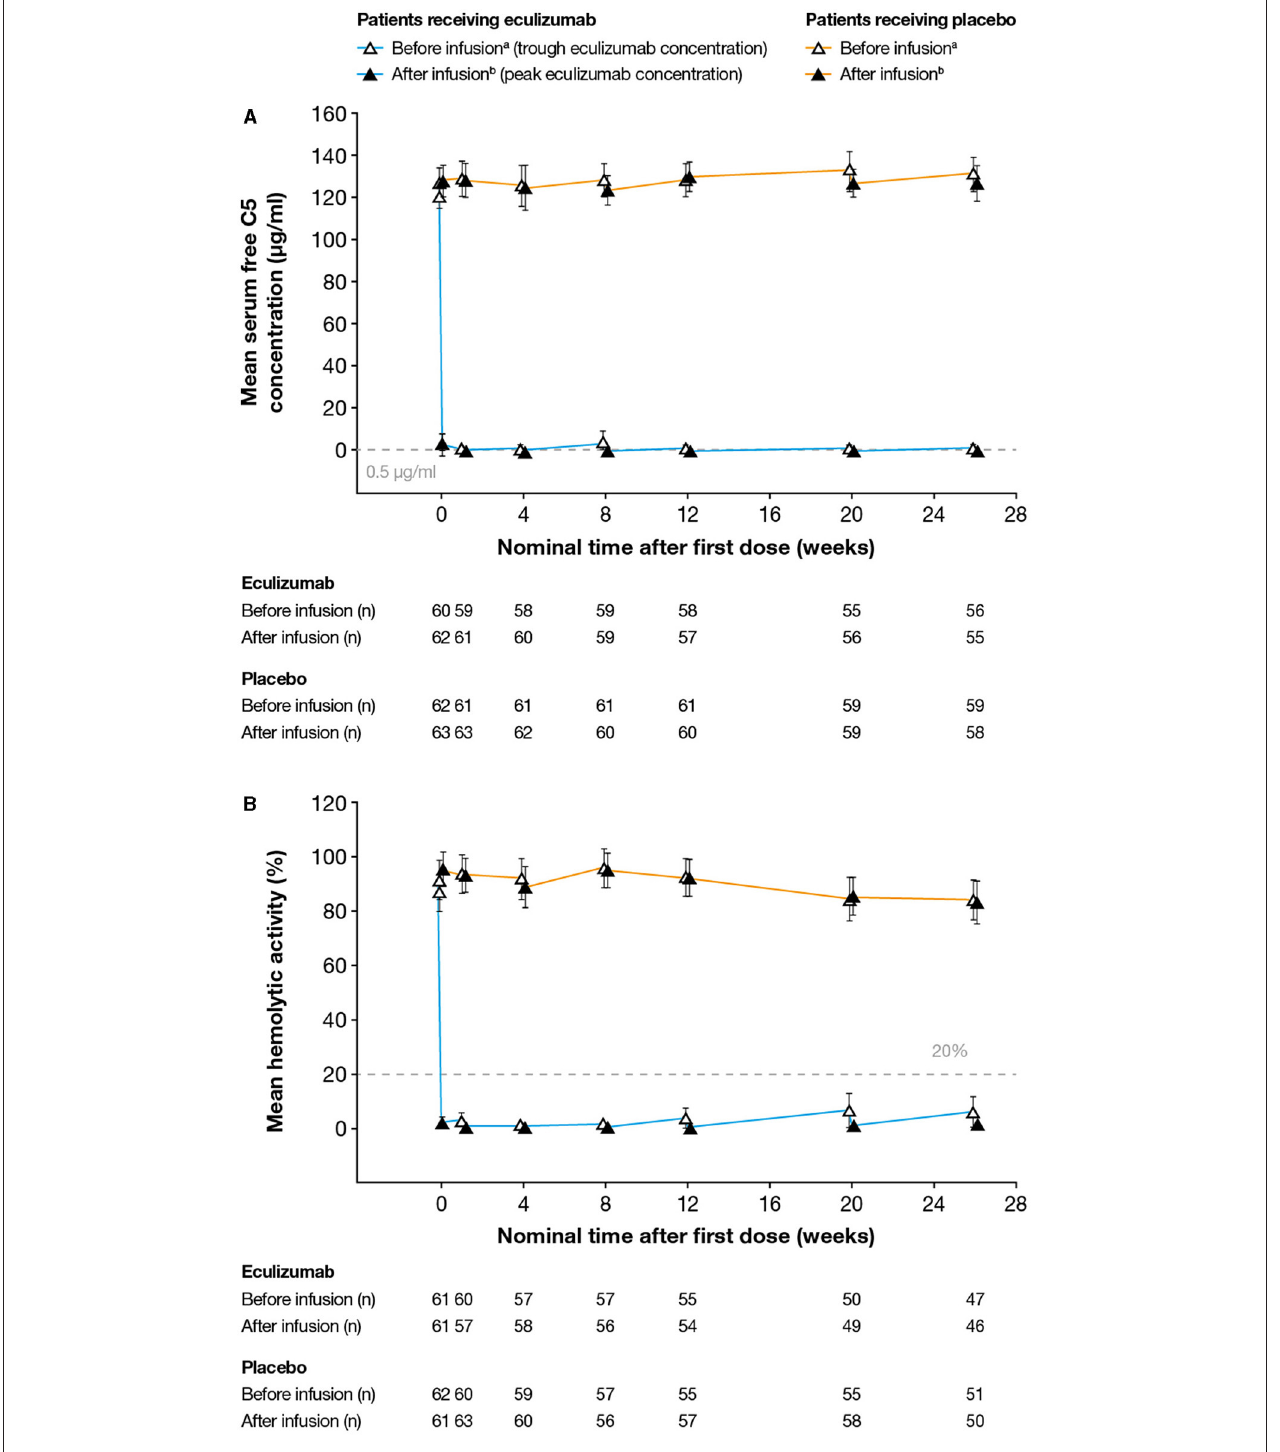
FIGURE 2 | Serum free C5 concentrations and complement-mediated hemolytic activity in serum during the study. (A) Mean (95% CI) serum free C5 concentrations. Free C5 concentrations below the lower limit of quantification (0.0274 µ g/ml) were analyzed as 0.0137 µ g/ml. Free C5 concentrations below 0.5 µ g/ml (dashed line) indicate complete terminal complement inhibition. (B) Mean (95% CI) percent in vitro complement-mediated hemolytic activity of serum samples. Hemolysis values above 20% (dashed line) indicate incomplete inhibition of hemolysis. For both analyses, samples were taken before and after eculizumab infusion (i.e., at eculizumab serum trough and peak concentrations, respectively); samples taken before and after infusion in patients receiving placebo are shown for comparison. a Samples taken 5–90min before infusion; b Samples taken 60min after the completion of infusion; c Day 1. The numbers reported below the graphs are the numbers of patients for whom samples were tested at that timepoint. C5, complement protein 5; CI, confidence interval.